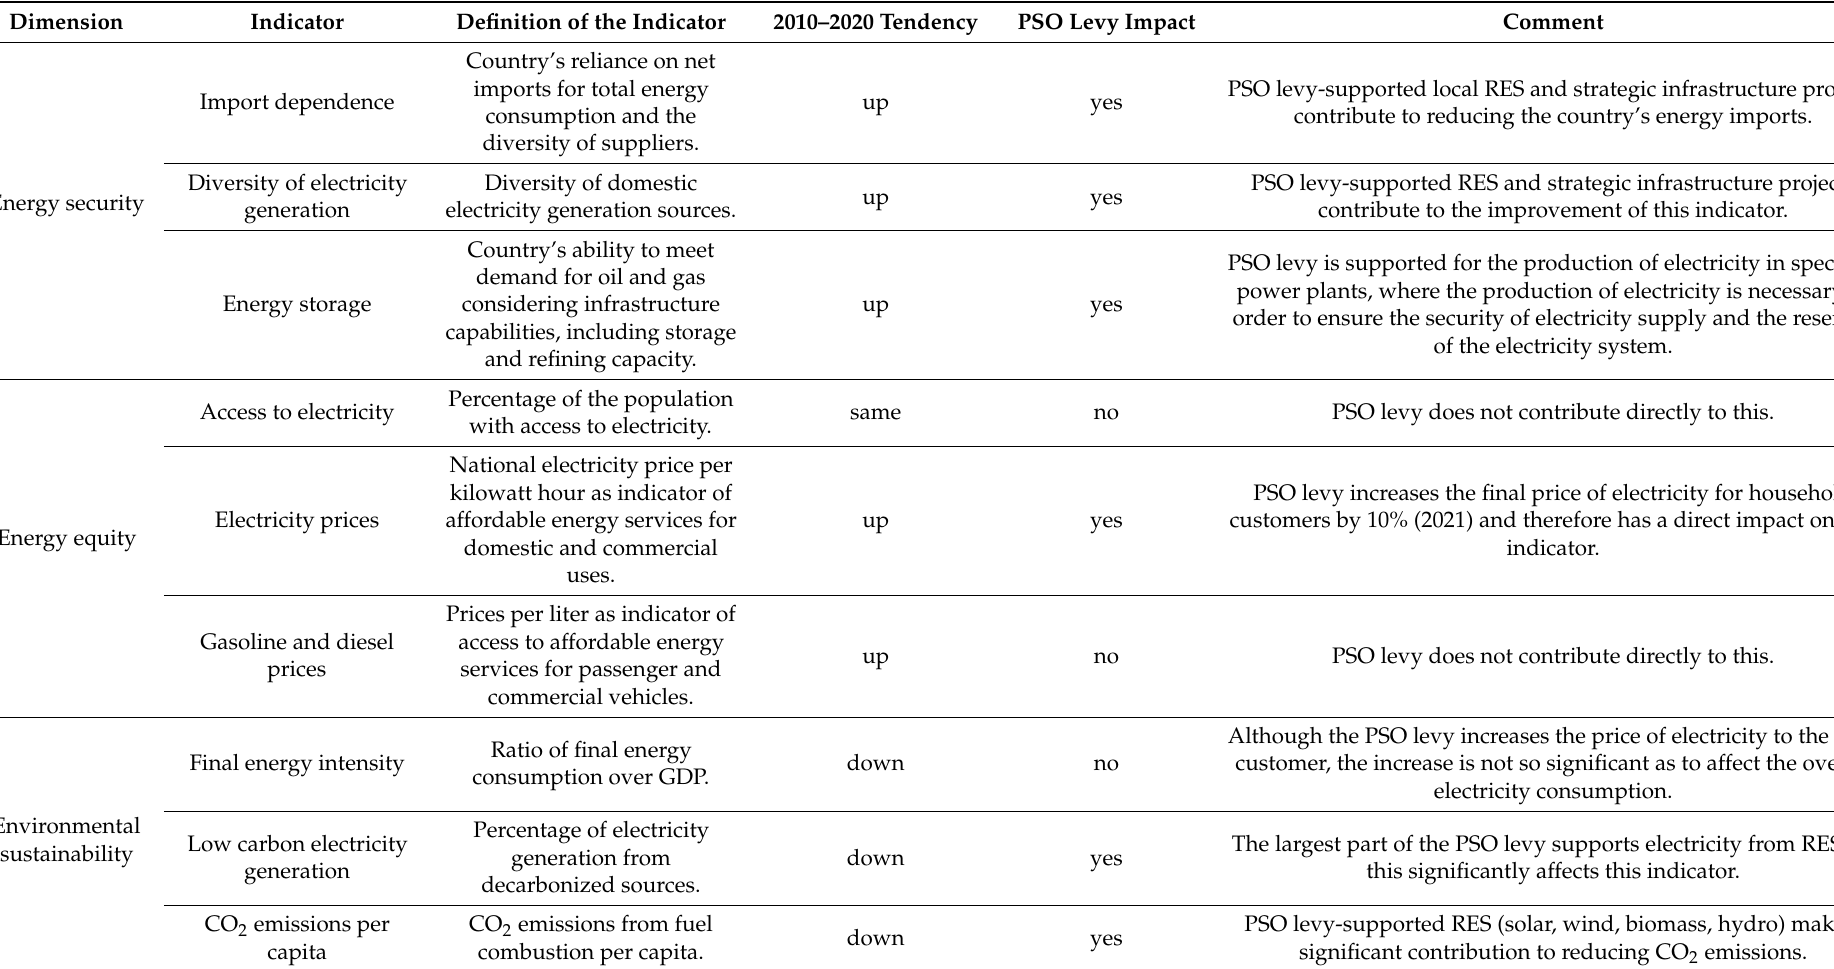
Table 8. PSO levy impact on Energy Trilemma Index for Lithuania (designed by the authors, based on